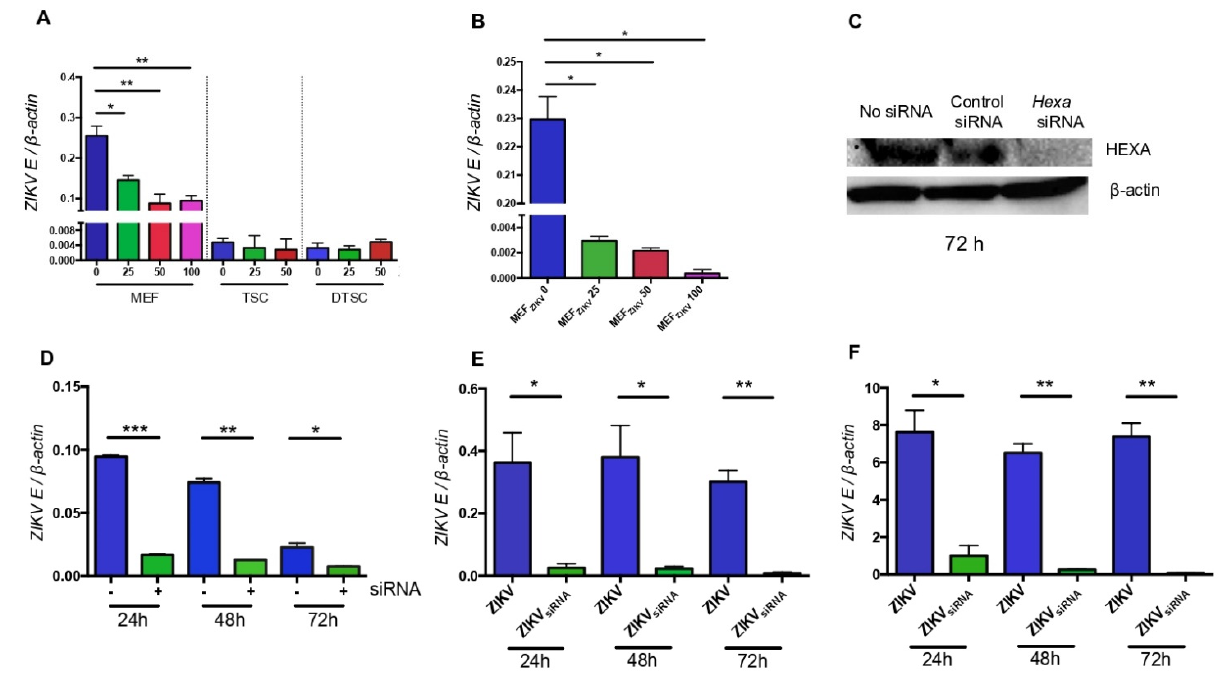
Figure 6. HEXA contributes to the glycosylation of ZIKV during the replication in TSCs and DTSCs. ( A ) MEFs, TSCs, and DTSCs were pre-treated with Z-Pugnac at different concentrations for 4 h, then infected with ZIKV (1 MOI) for 24 h, and the viruses in the cells were quantified by qPCR. ( B ) Vero cells were infected with ZIKV generated in MEFs in the presence of Z-Pugnac for 24 h, and the viral replication was quantified by measuring the ratio of ZIKV E to cellular β -actin with qPCR. ( C ) Vero cells were transfected with HexA siRNA or randomized siRNA as a control for 72 h. The levels of HEXA and β -Actin were measured by immunoblotting. ( D ) Vero cells were transfected with HexA siRNA, then infected with ZIKV (1 MOI). After 24 h of infection, the level of ZIKV E was quantified by qPCR and normalized to β -actin . ( E ) ZIKV and ZIKV grown in HexA siRNA-transfected cells were used to infect Vero cells with 0.1 MOI. After 1 h of infection at 4 ◦ C, the level of viruses attached to the cells was quantified by qPCR. ( F ), Vero cells were infected with 0.1 MOI of ZIKV and ZIKV grown in the presence of HexA siRNA for 24, 48, and 72 h at 37 ◦ C for 24 h, and the levels of the viral replication were measured by qPCR. The results were analyzed by either one-way ANOVA followed by Tukey’s test ( A , B ) or a two-tailed Student’s t -test ( D – F ). The results are representative of at least two independent experiments and are expressed as mean ± SEM. *, **, and *** denote p < 0.05, p < 0.01, and p < 0.001, respectively.